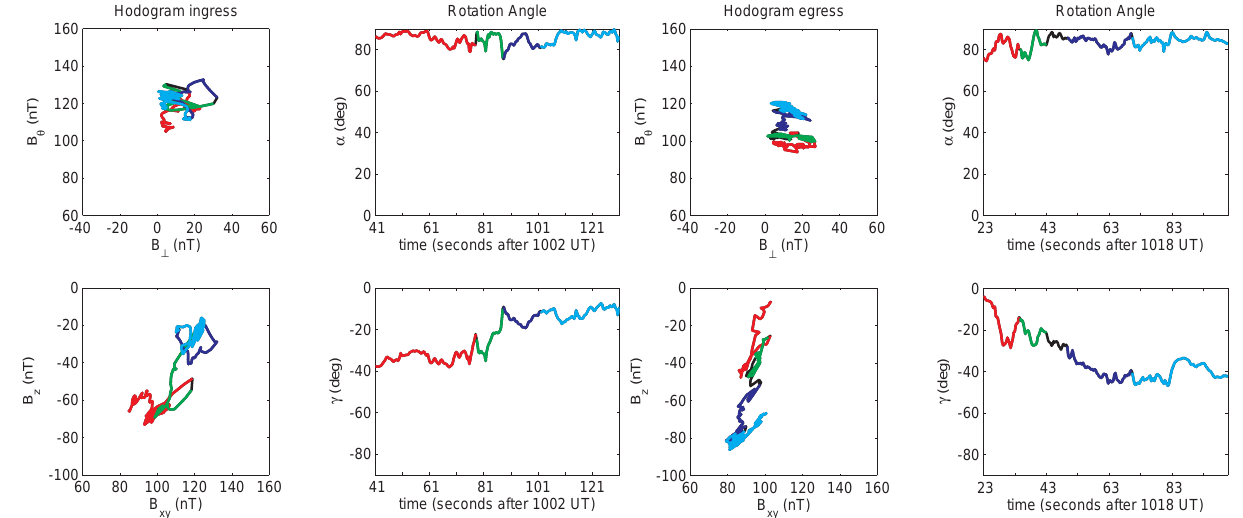
Fig. 8. Left: G28 inbound magnetopause crossing hodogram for the interval 10:02:40–10:04:12UT. Right: the same for the G28 outbound magnetopause crossing for the interval